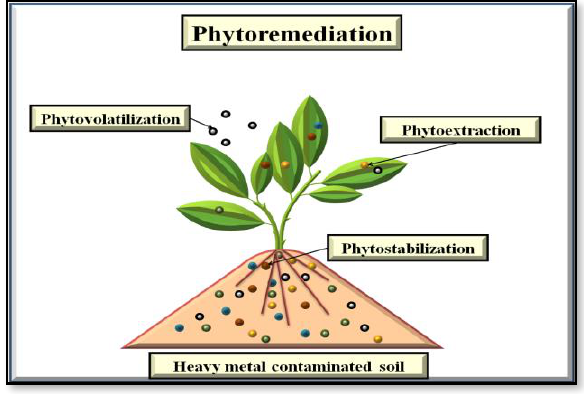
Figure 5. Phytoremediation for heavy metals and its mechanisms